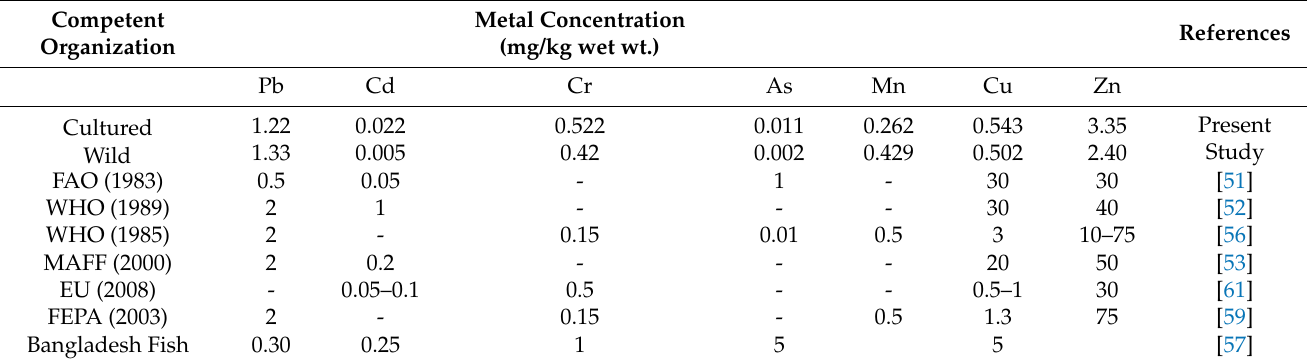
Table 2. Maximum permissible limit (MPL) of heavy metals in fish muscles (mg/g wet wt.) according to international